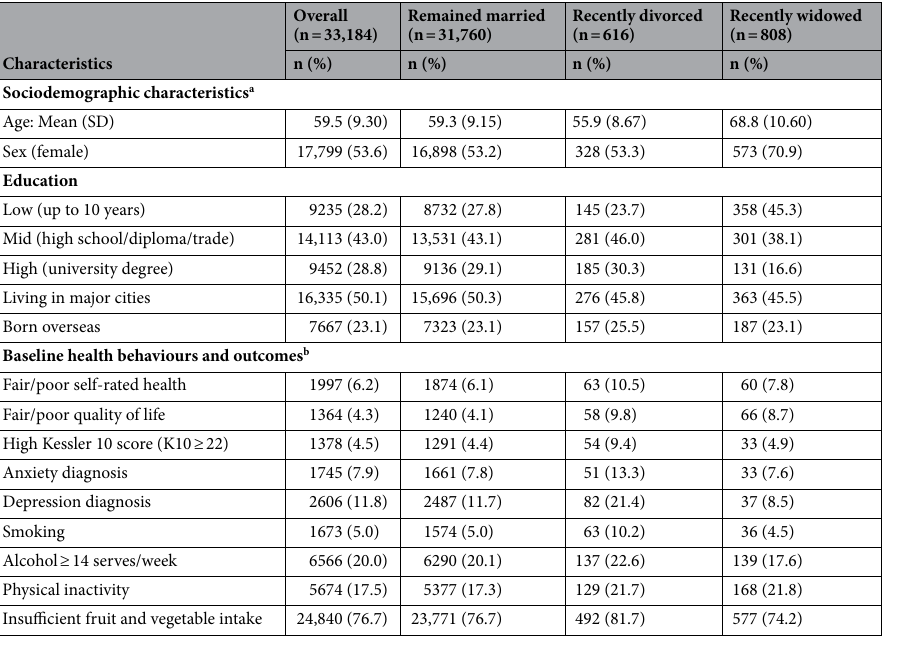
Table 2. Baseline (T1, 2006–2009) characteristics of participants by marital status at T2 (2010). T1: baseline data collection (2006–09), T2: first follow-up: 2010. Remained married: married at T1 and T2; Recently divorced: married at T1 and divorced/separated at T2; Recently widowed: married at T1 and widowed at T2. a Sociodemographic characteristics differed significantly by marital status at T2 ( p < 0.001) for all variables except for “born overseas” ( p = 0.227). b All baseline health behaviour and outcome variables differed significantly by marital status ( p <